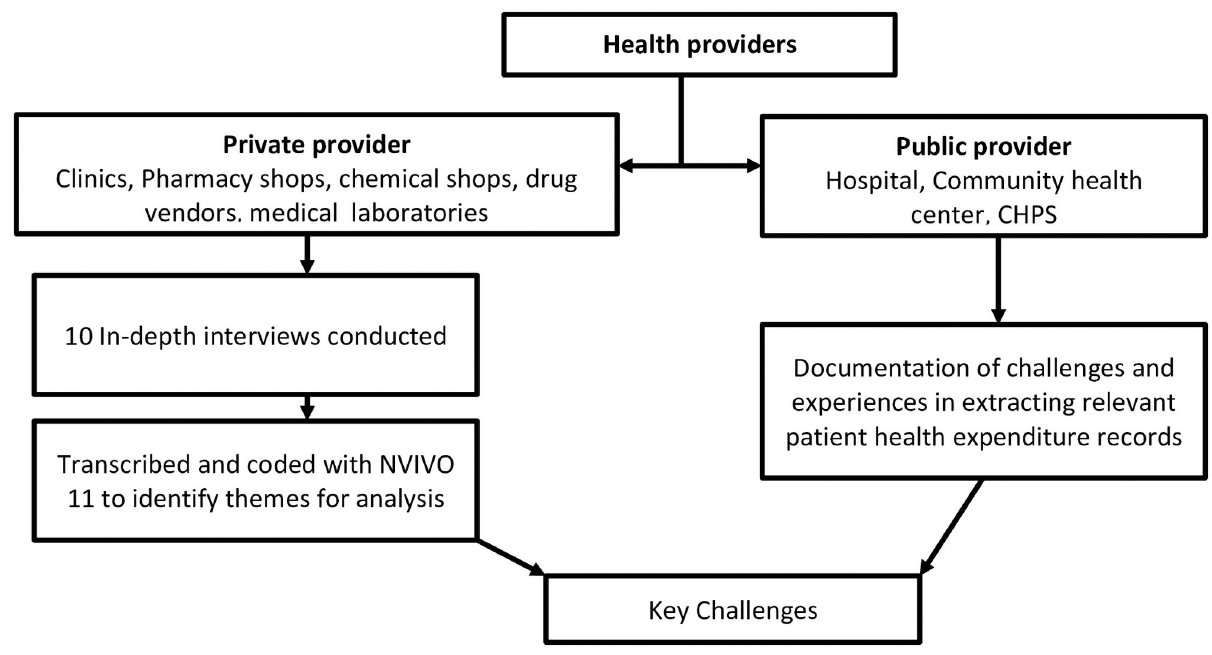
Fig 1. Structure of data processing for qualitative